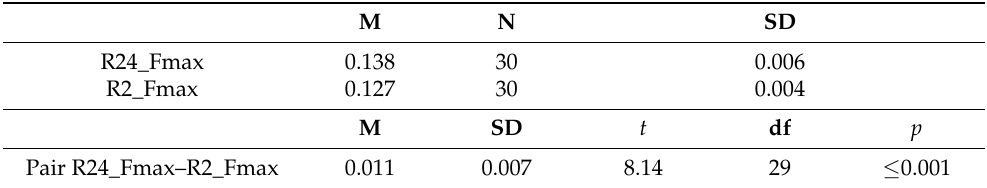
Table 3. Paired-samples test: pair R24_Fmax–R2_Fmax. M N SD R24_Fmax 0.138 30 0.006 R2_Fmax 0.127 30 0.004 M SD t df p Pair R24_Fmax–R2_Fmax 0.011 0.007 8.14